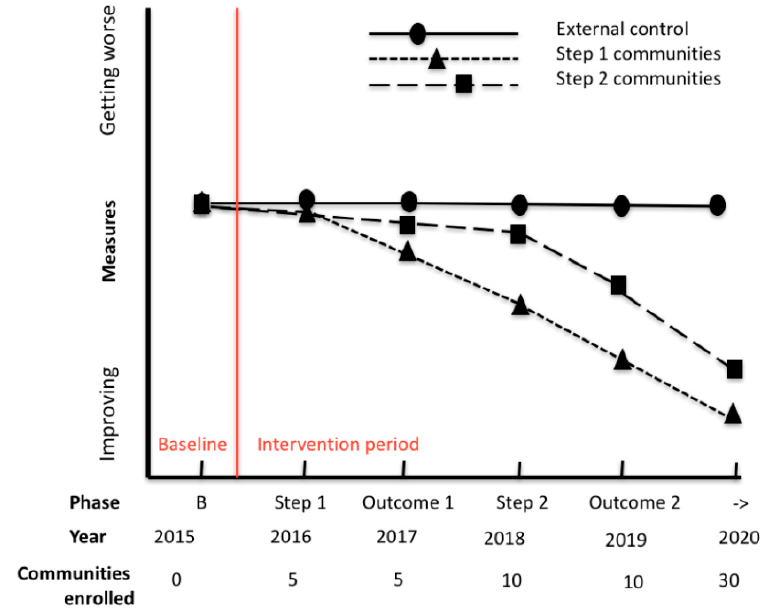
Figure 2. Hypothesis testing over time for the WHO STOPS